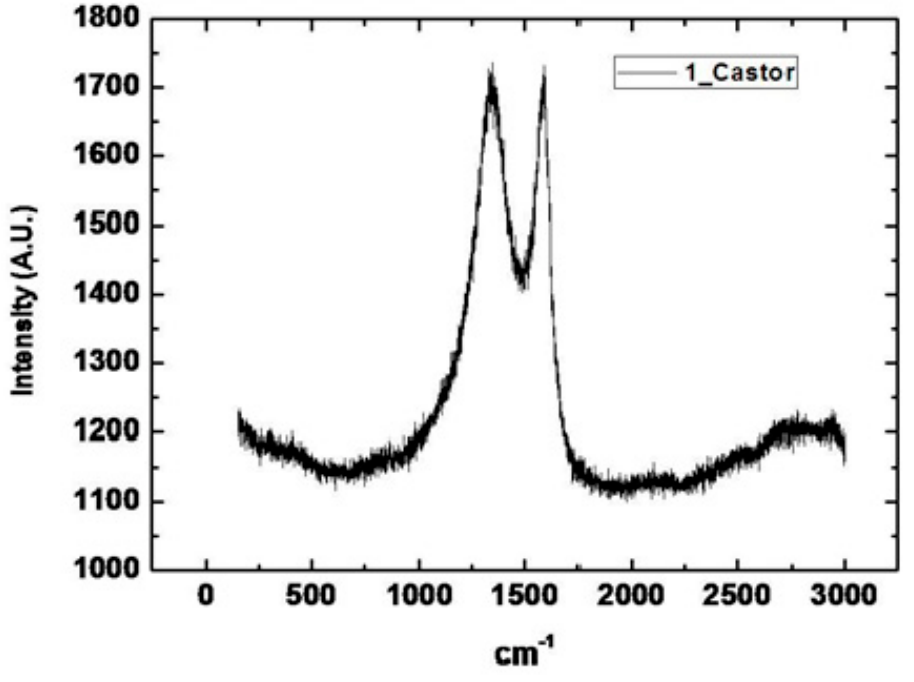
Figure 5. FTIR image of castor oil emission powder.